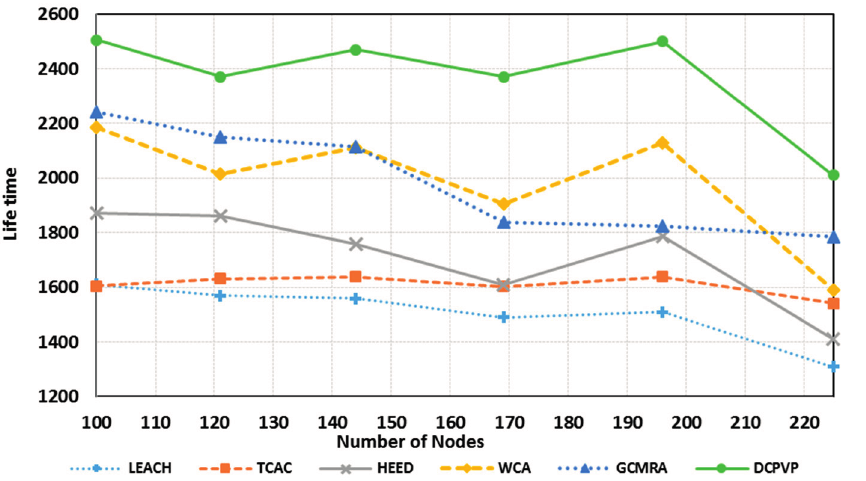
Figure 13. Comparison of the network lifetime in uniform distribution.